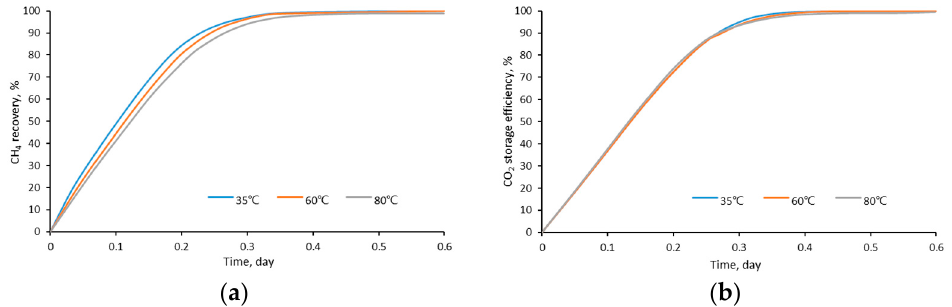
Figure 19. The variation curves under different temperatures. ( a ) CH 4 recovery; ( b ) CO 2 storage efficiency.